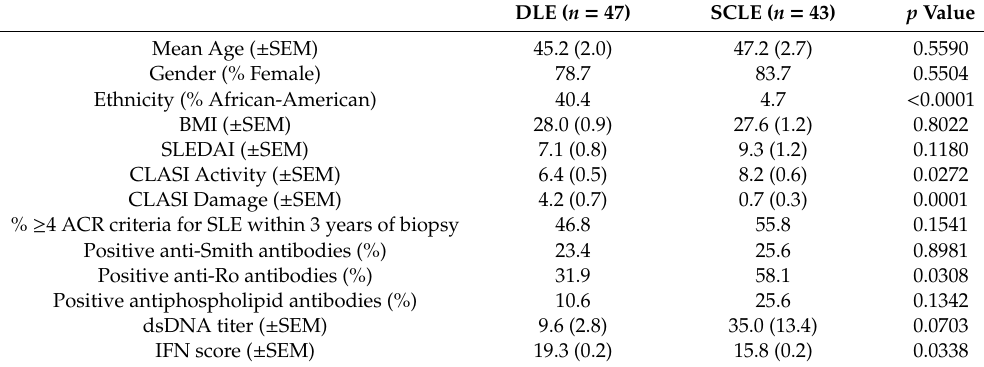
Table 1. Summary Characteristics of lupus patients included in the microarray study. Comparisons between DLE and SCLE were made using two-sided unpaired Students’ t